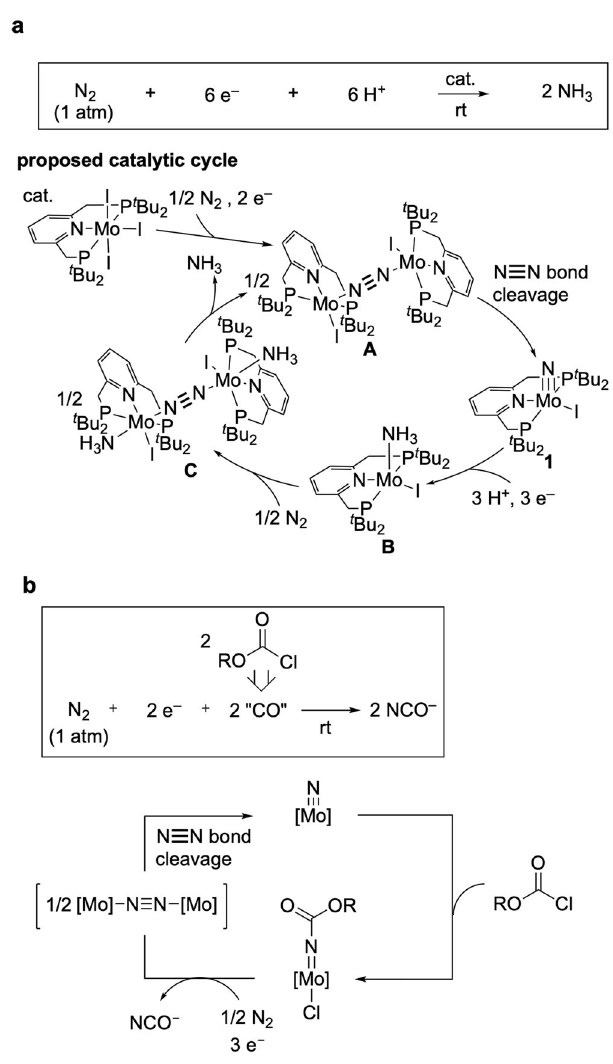
Fig.2|Catalyticreactionsfromdinitrogenunderambientreactionconditions. a Previouswork:catalyticammoniaformationviathedirectcleavageofdinitrogen; b